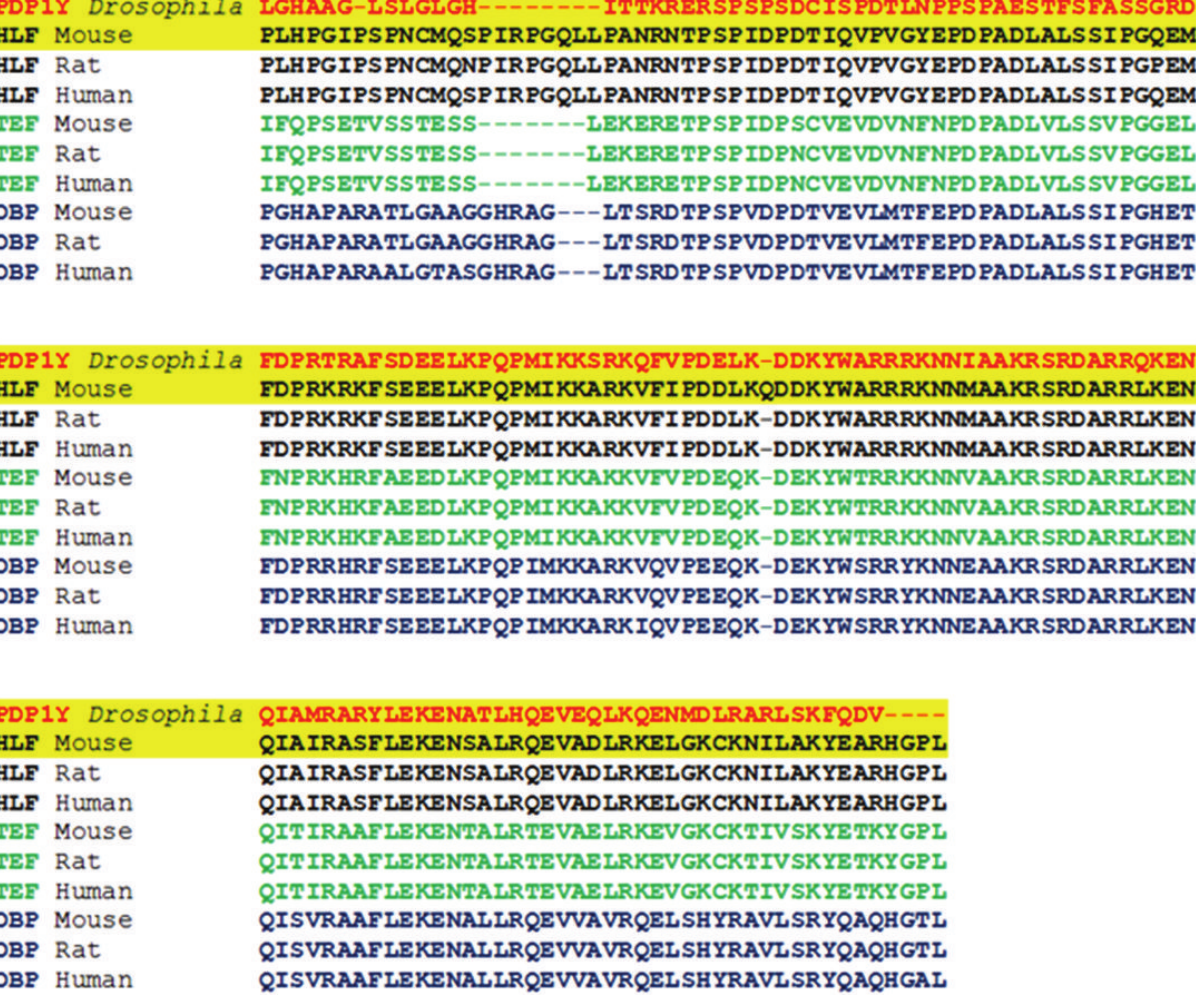
Figure 4: Homology between Drosophila PDP1 𝛾 and mammalian bZIP transcription factors HLF, TEF, and DBP. Shown is the protein sequence alignment in the b-ZIP structural regions with the highest homology, analyzed using the online CLUSTALW multiple sequences alignment tool [13]. The NCBI database accession information is as follows. Drosophila PDP1 𝛾 Q9TVQ4; HLF: mouse NP 766151, rat Q64709, and human NP 002117; TEF: mouse NP 059072, rat NP 062067, and human NP 003207; DBP: mouse NP 058670, rat NP 036675, and human NP 001343. Highlighted in yellow are the sequences of Drosophila PDP1 𝛾 and mouse